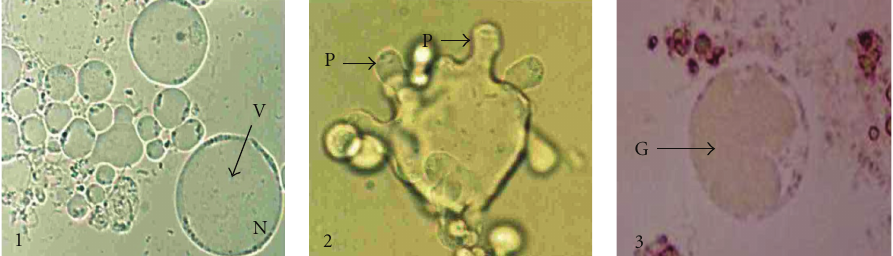
Figure 2: Blastocystis cells ( × 400) from water samples showing the vacuolar (1), amoeboid (2), and granular (3) forms. V: vacuole, N: sandy nuclei, P: pseudopodia, G: vacuole with